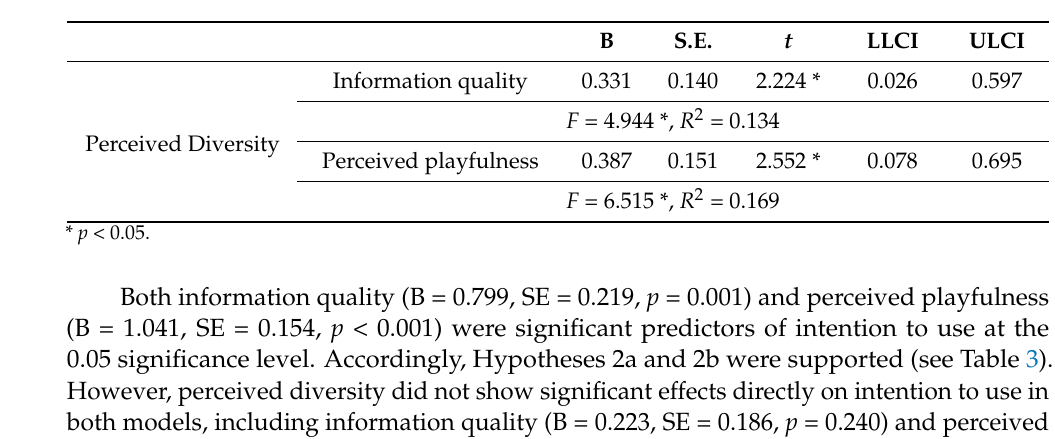
Table 3. Results of the mediation analyses of the effects of information quality and perceived playfulness on intention to use for H2a and H2b. B S.E. t ULCI Information quality Intention to use Perceived playfulness